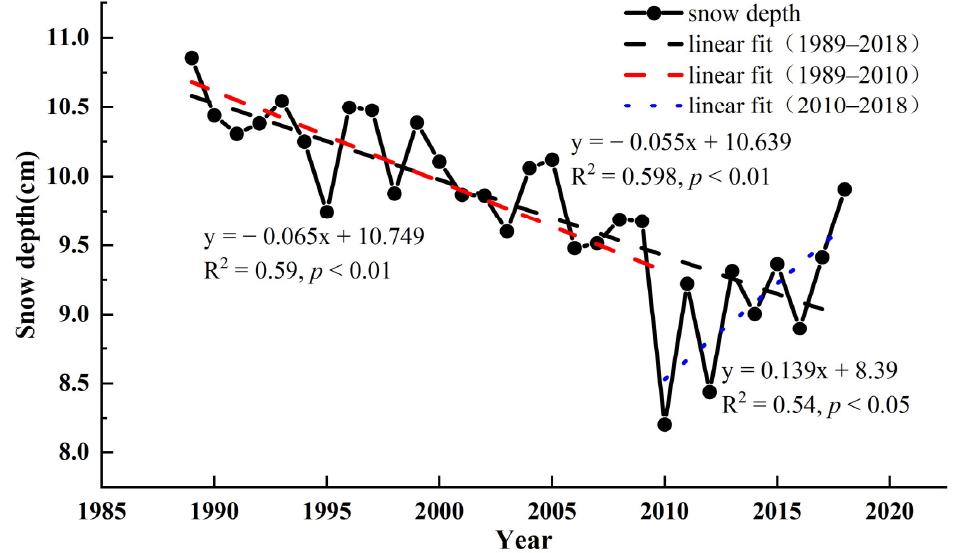
Figure 5. Interannual SD variations in the NH.